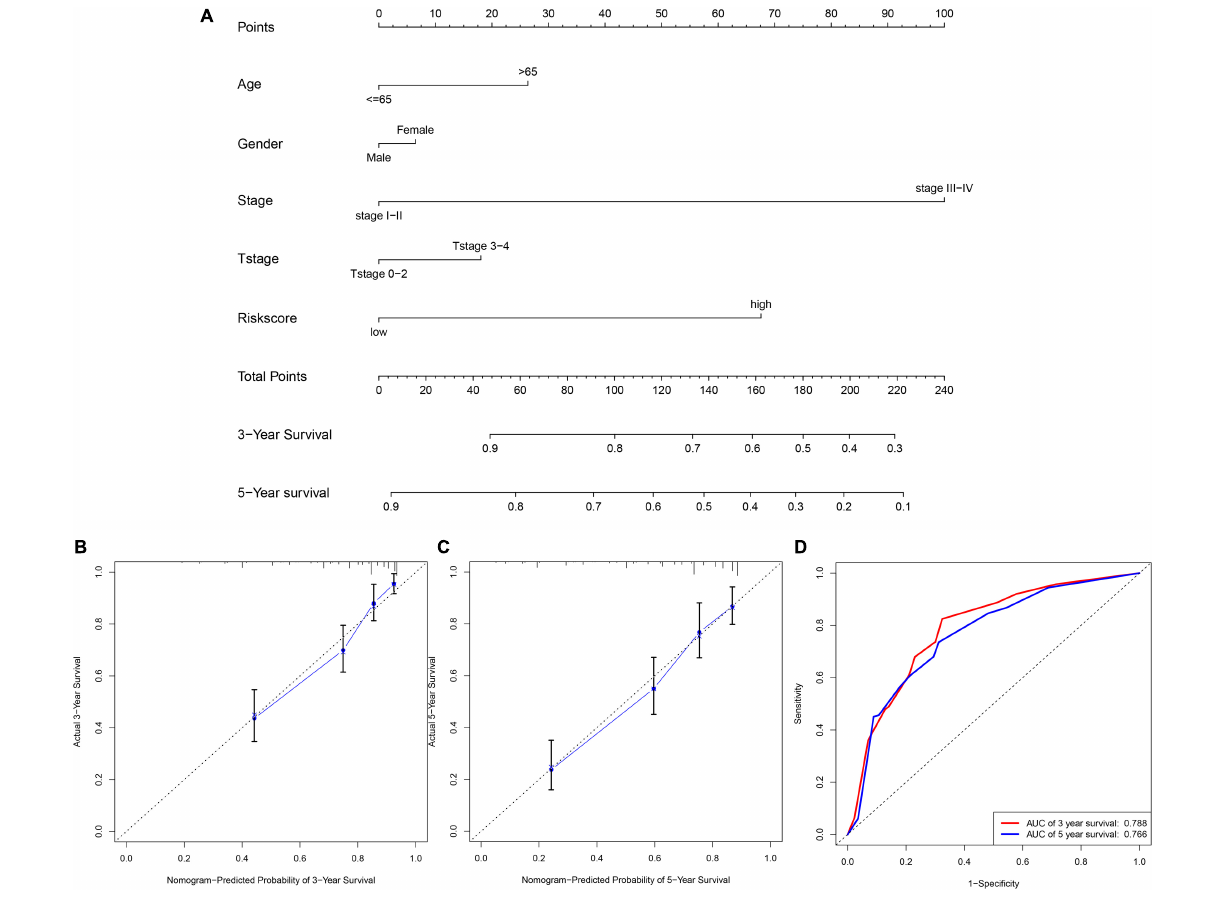
FIGURE 5 | The nomogram based on clinicalpathological parameters and risk score. (A) The nomogram shows that the risk score accurately estimate the 3-, and 5-year survival time. (B,C) Calibration curves elucidate the concordance between predicted and observed 3- and 5-year OS of RCC patients. (D) ROC curve shows the AUC values (0.788 and 0.766) of 3- and 5-year